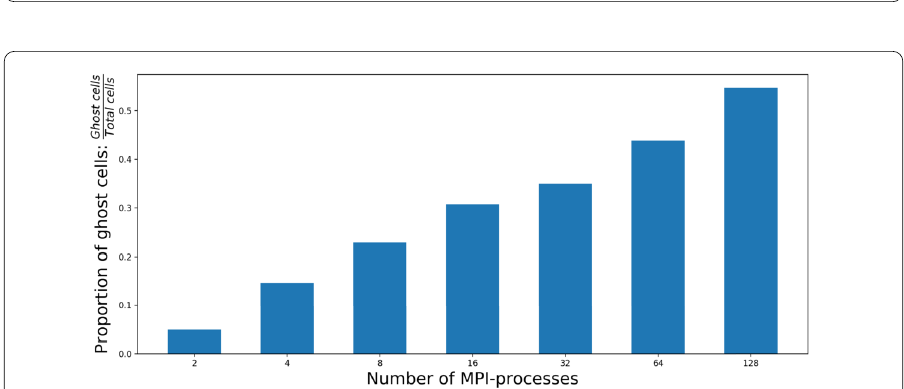
Figure 4 Ratio of the ghost cells related to partitioning the Norne reservoir